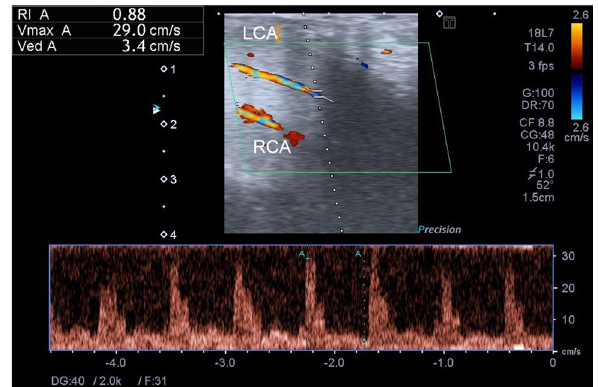
Figure 2. An example of dynamic duplex sonography of the penis. Both LCA and RCA are shown in this sonography. The hemodynamic parameters of the LCA are measured. The PSV (shown as Vmax A) is 29.0 cm/s, the EDV (shown as Ved A) is 3.4 cm/s, and the RI (shown as RI A) is 0.88. EDV: end-diastolic velocity, LCA: left cavernous artery, PSV: peak systolic velocity, RCA: right cavernous artery, RI: resistance